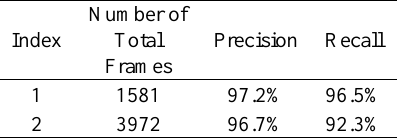
Table 1. Recognition Statistics of the Proposed Algorithm